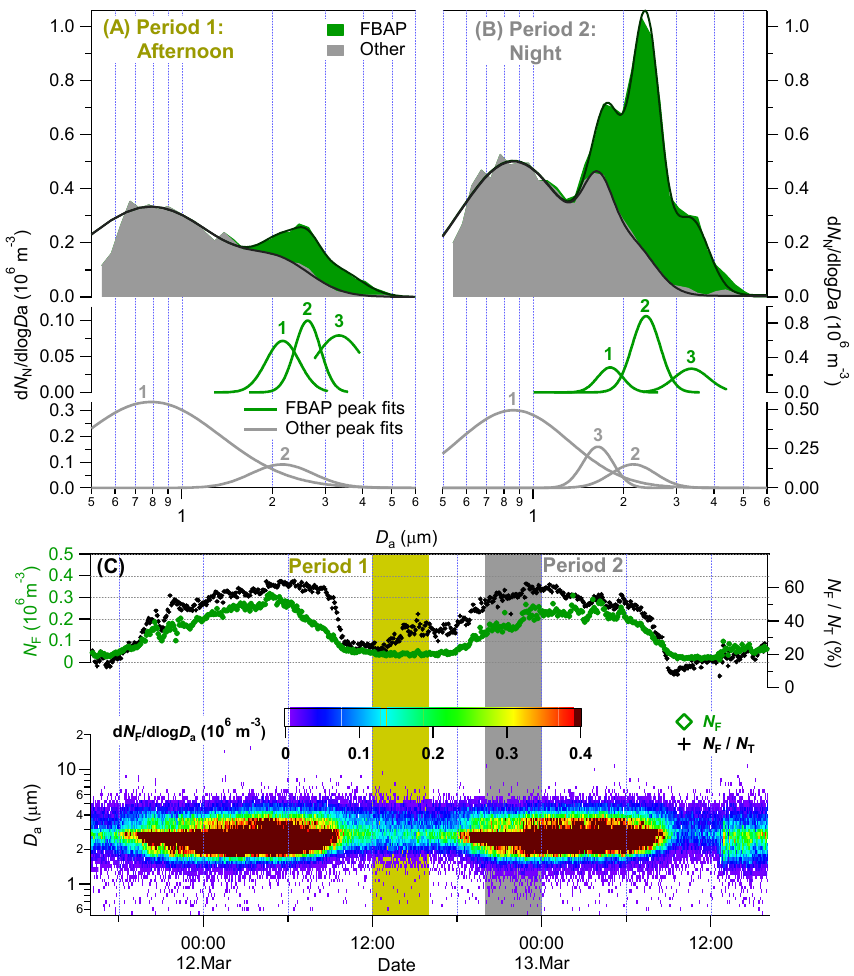
Fig. 10. (A) and (B) Particle size distributions of fluorescent and non-fluorescent aerosol for two individual four-hour blocks on 12 March. Top panels show stacked size distributions from UV-APS. Individual traces below show peaks fit to FBAP (green) and non-FBAP (gray) with number label of each peak. Sum of all peak fits shown in top panel is dark lines. (C) Size distribution, integrated number, and ratio of FBAP/total for each 5-min data point. Yellow bar indicates Period 1 (Afternoon: 12:00–16:00), gray bar indicates Period 2 (Evening: